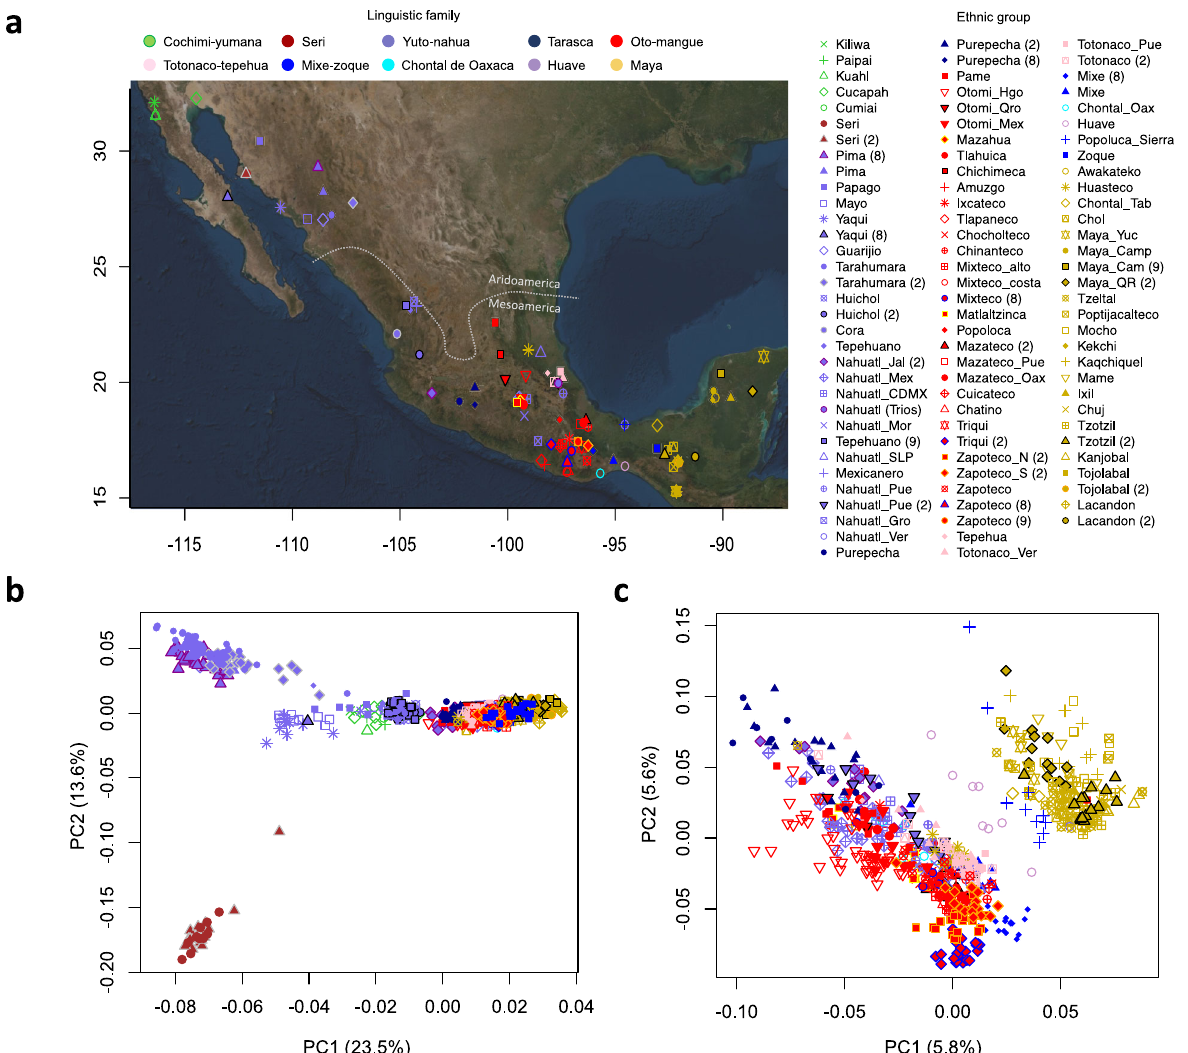
Fig. 1 Geographic distribution and genetic relationships of Indigenous populations in Mexico. a Map with locations of the sampled communities. The points in the map denote the approximate location where each ethnic group samples were collected. b PCA projection of all Mexican Indigenous groups tested, with the fi rst two axes of variation differentiating ethnic groups from Aridoamerica and Mesoamerica. c PCA projection of Indigenous groups from Mesoamerica that resembles the geography of central and southern Mexico. Dot shapes denote the ethnic group and color the linguistic family according to INALI classi fi cation. Numbers between brackets are the corresponding